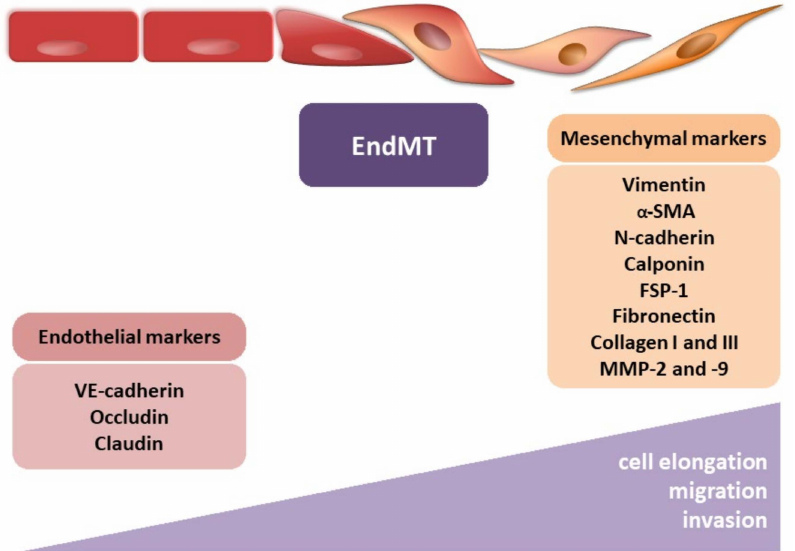
Figure 3. Endothelial–mesenchymal transition. The figure illustrates the morphological modulation (cell elongation) and increasing migration and invasion ability of mesenchymal cells. The observed phenotypic alterations are accompanied by changes in gene expression, i.e., decrease in endothelial markers (VE-cadherin, occludin, and claudin) and increase in mesenchymal markers (vimentin, α - smooth muscle actin ( α -SMA), N-cadherin, calponin, fibroblast-specific protein-1 (FSP-1), fibronectin, collagen I, collagen III, metalloproteinase-2 (MMP-2), and metalloproteinase-9